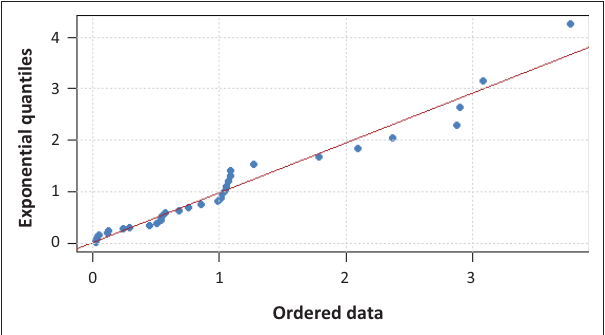
FIGURE 7: South Africa – Diagnostic plot for peak over threshold analysis: Tail of the underlying distribution.